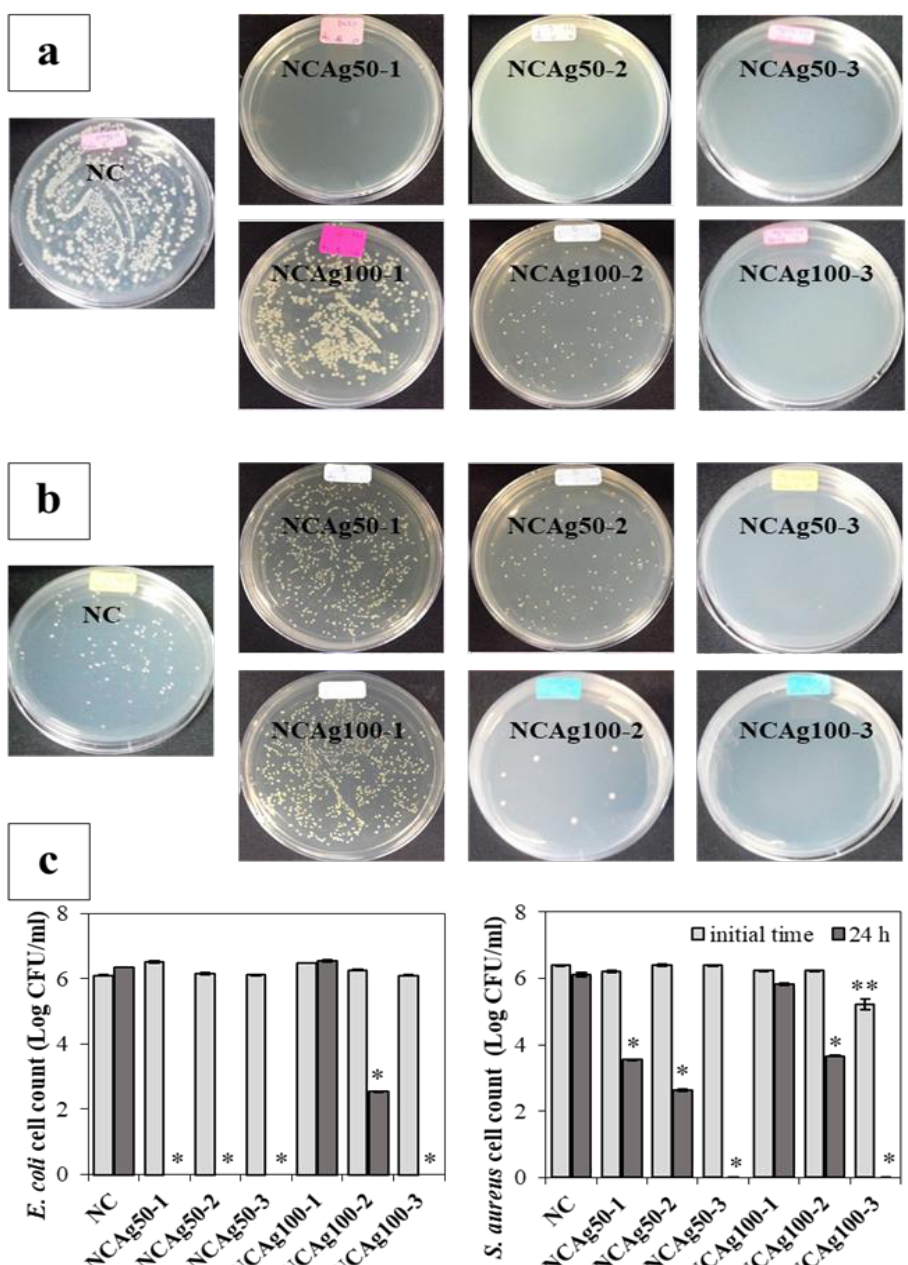
Figure 9. Antibacterial activity of NC and NCAg films against E. coli ( a ) and S. aureus ( b ) investigated by the plate count method, and quantitative colony counting ( c ) at 0 h ( ◼ ) and 24 h ( ◼ ). The symbols ** and * indicate a significant difference ( p > 0.05, n = 3) vs. NC at 0 h and 24 h, respectively.